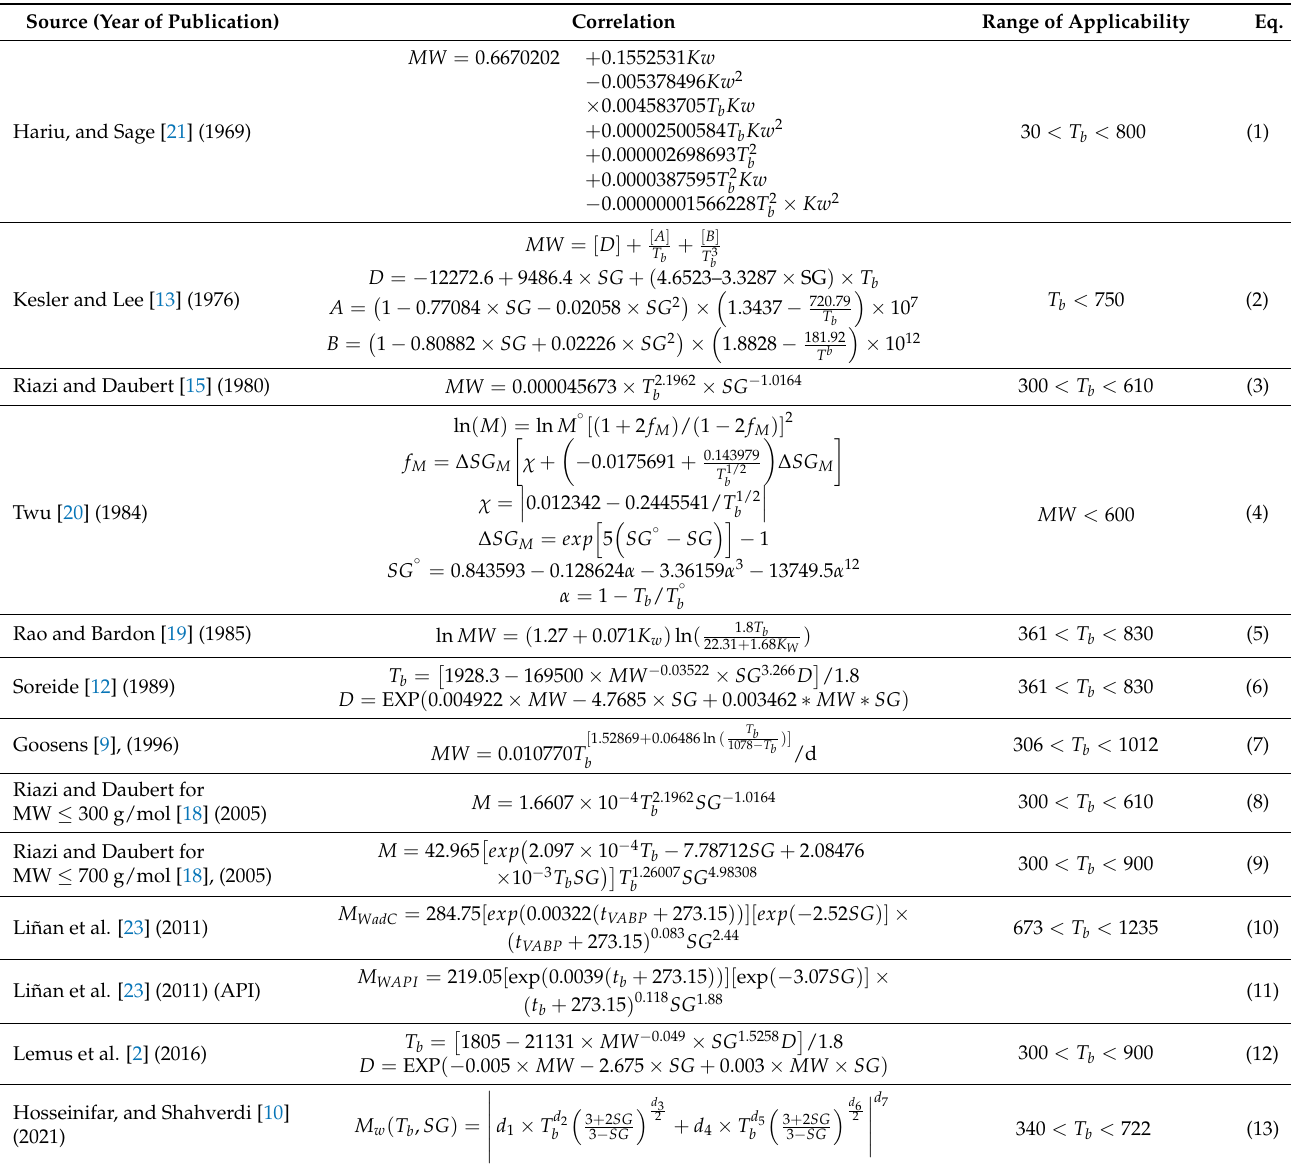
Table 1. Summary of correlations available in the literature to estimate molecular